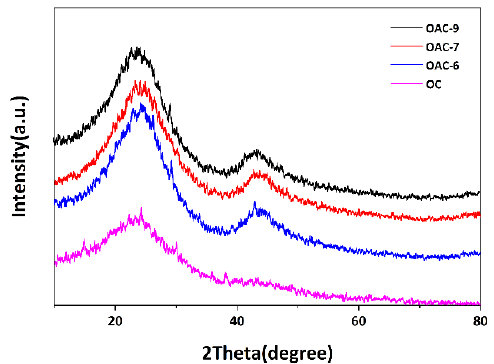
Figure 2. XRD patterns of OC, OAC − 6, OAC − 7, and OAC − 9.